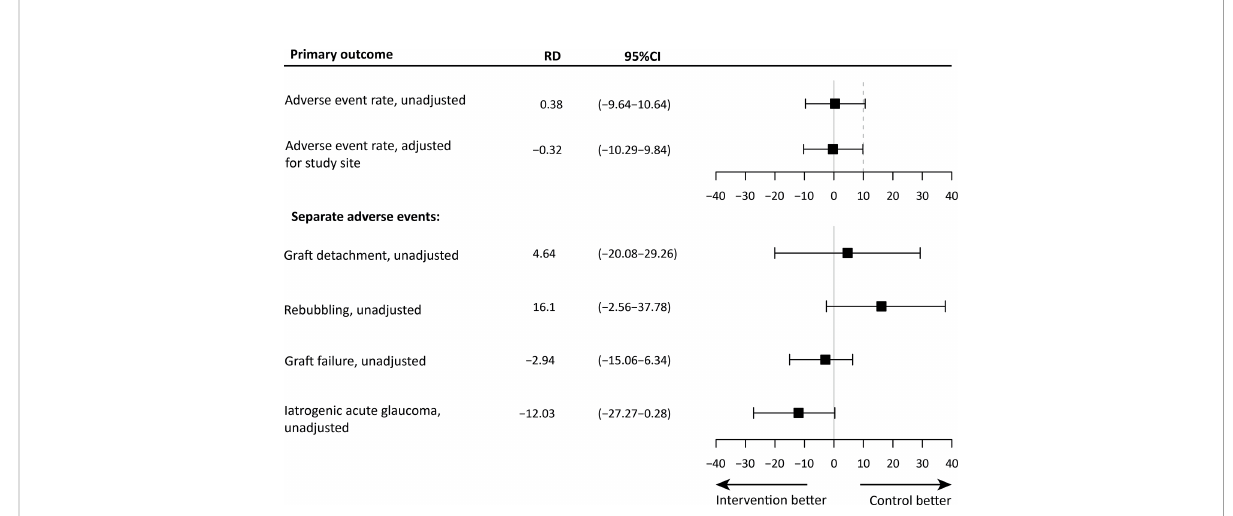
FIGURE 2 The mean risk difference (RD) and 95% con fi dence interval (CI) of the outcome measures, and the non-inferiority limit (dashed line). The top panel shows the unadjusted and adjusted estimates for the primary outcome measure. The bottom panel shows the unadjusted estimates for all separate postoperative events. For these outcomes, a non-inferiority margin is not